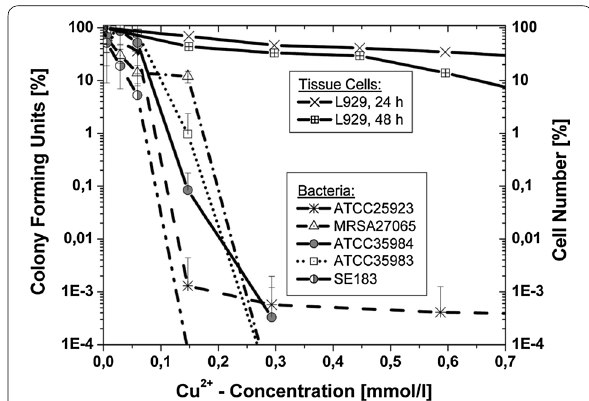
Fig. 2 Cell number of fibroblasts L929 and colony forming units of different bacterial strains in dependence of Cu 2 + -content in the